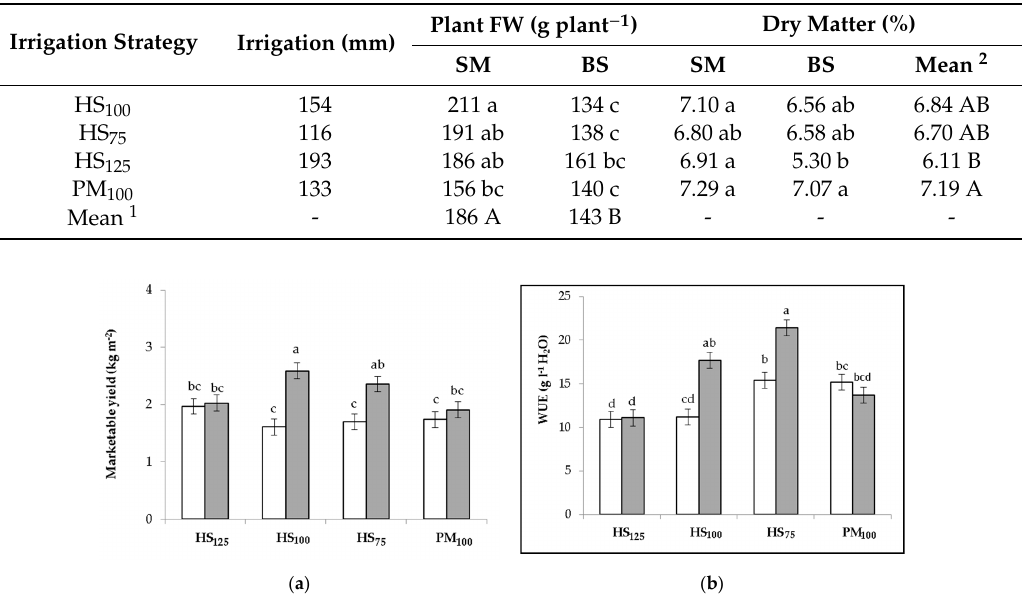
Figure 2. Experiment 2: Effect of irrigation strategy (HS 175 = recovery of 125% ET c calculated by the Hargraves–Samani equation; HS 100 = recovery of 100% ET c calculated by the Hargraves–Samani equation; HS 75 = recovery of 75% ET c calculated by the Hargraves–Samani equation; PM 100 = recovery of ET c calculated by the Penman–Monteith equation) and mulching (white bars, no mulched, black bars, mulched) on soil-grown lettuce’s ( a ) marketable yield (kg FW m − 2 ) and ( b )water use efficiency (WUE, g FW L − 1 H 2 O). Vertical bars indicate SE, different letters indicate significant differences with p ≤ 0.05.